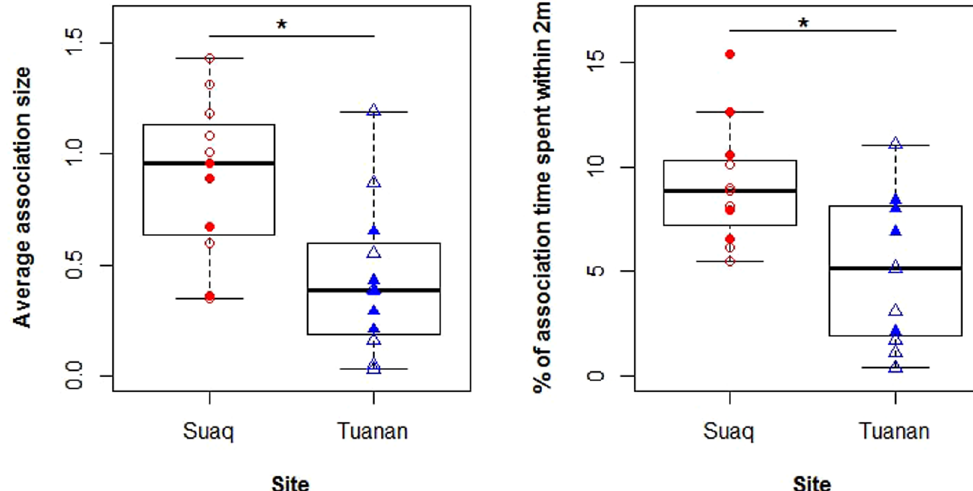
Figure 1. Average number of associates (excluding the mother and semi-dependent siblings) for dependent immatures at Suaq and Tuanan ( a ); and percent of association time spent within two meters of adult association partners other than the mother ( b ). Open symbols refer to dependent immatures from 0–2.9 years and filled symbols to dependent immatures from 3–6